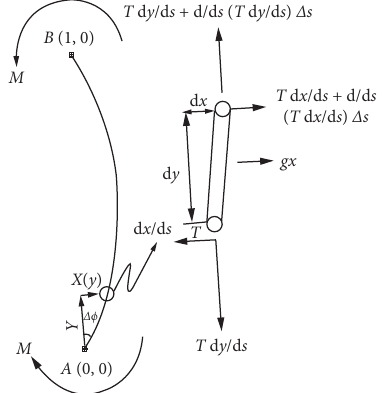
Figure 2: Schematic of cable/hanger